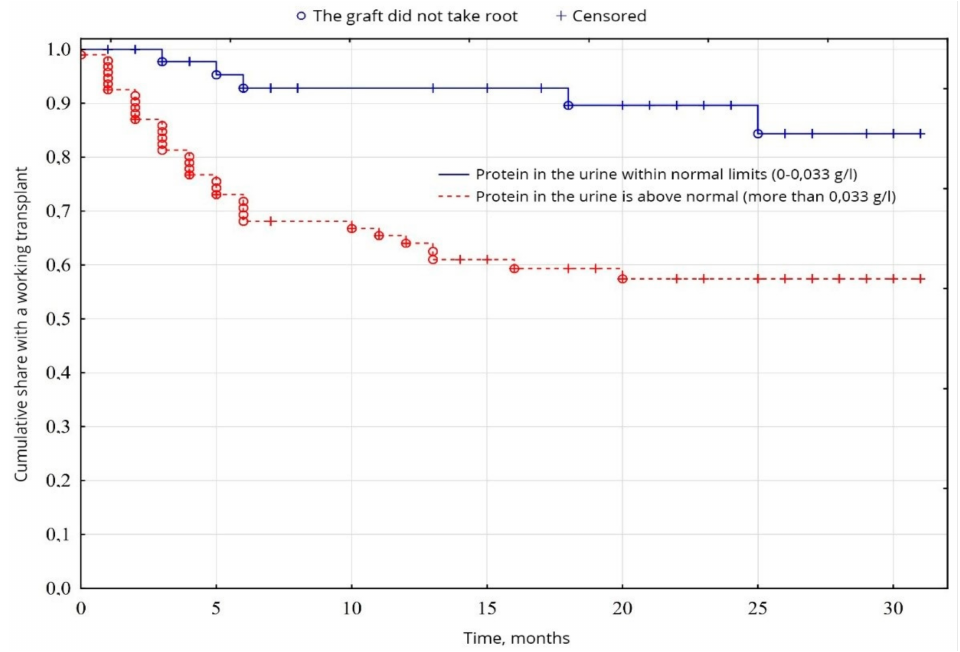
Figure 7. Evaluation of graft function depending on